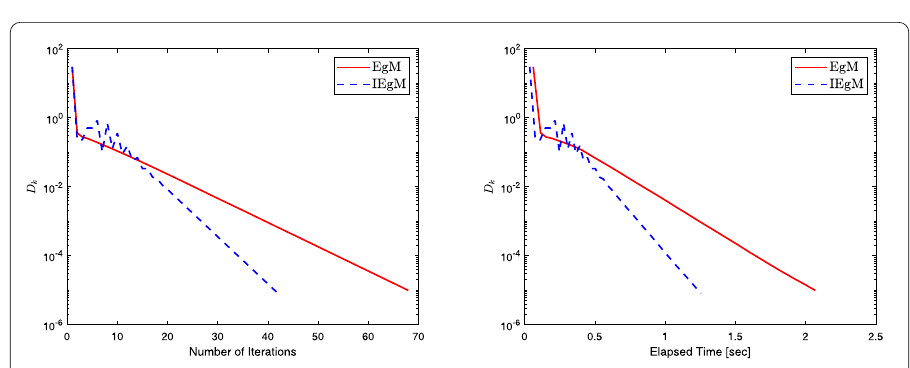
Figure 12 Computational comparability of Algorithm 2 with Algorithm 3.1 in [36] for M = 100